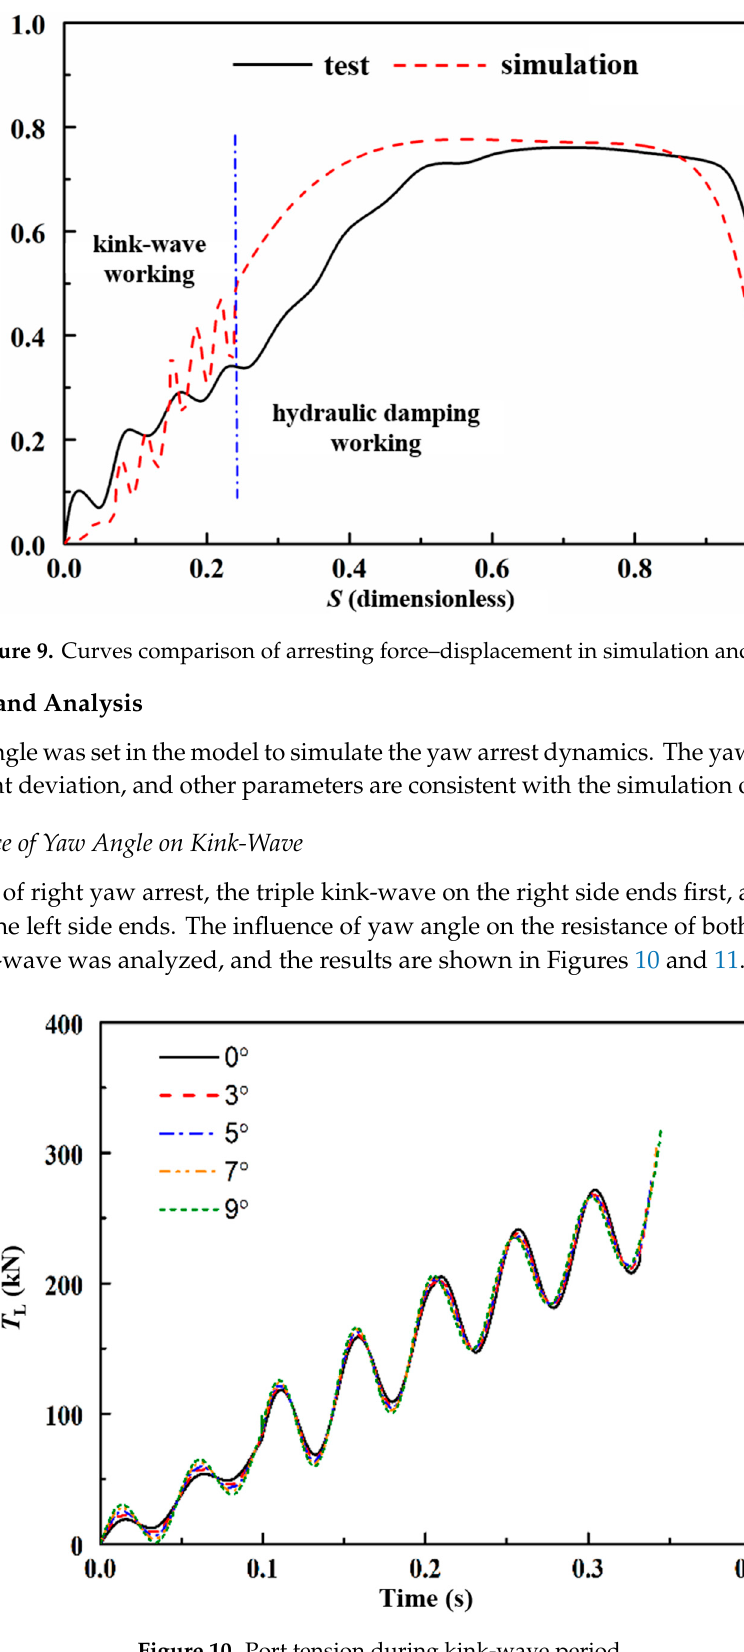
Figure 10. Port tension during kink-wave period.